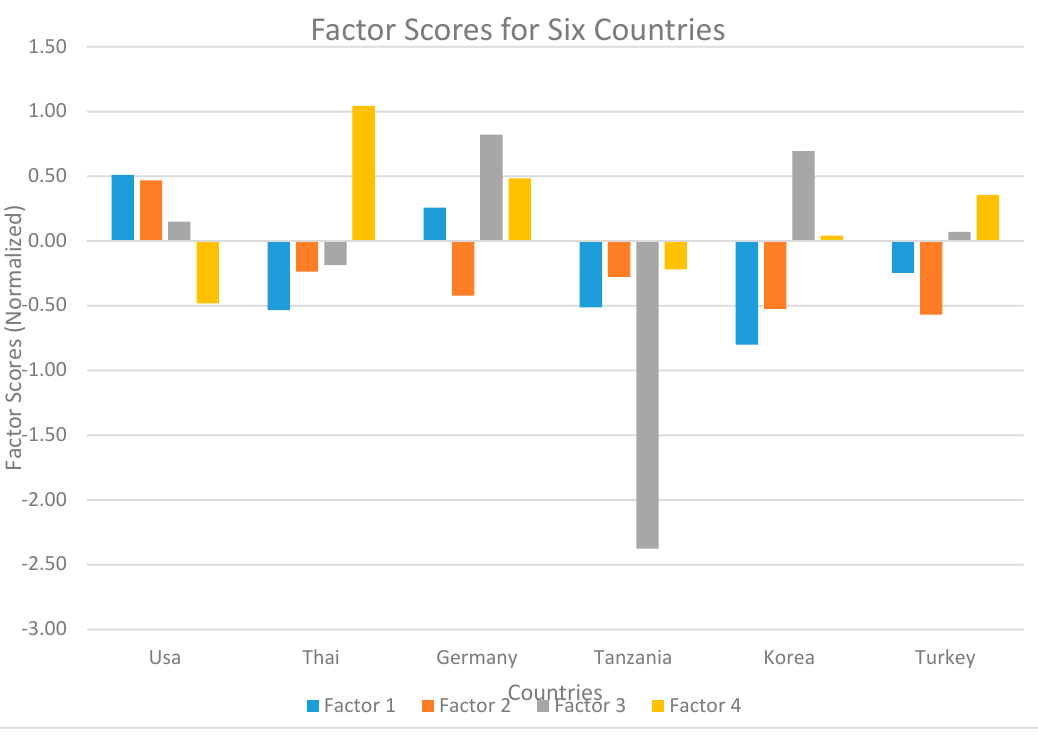
Figure 2. Component Factor Analysis by Country (4 × 6).